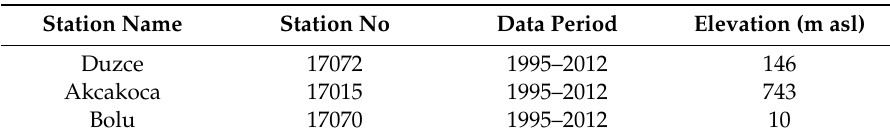
Table 2. Local climate stations and related